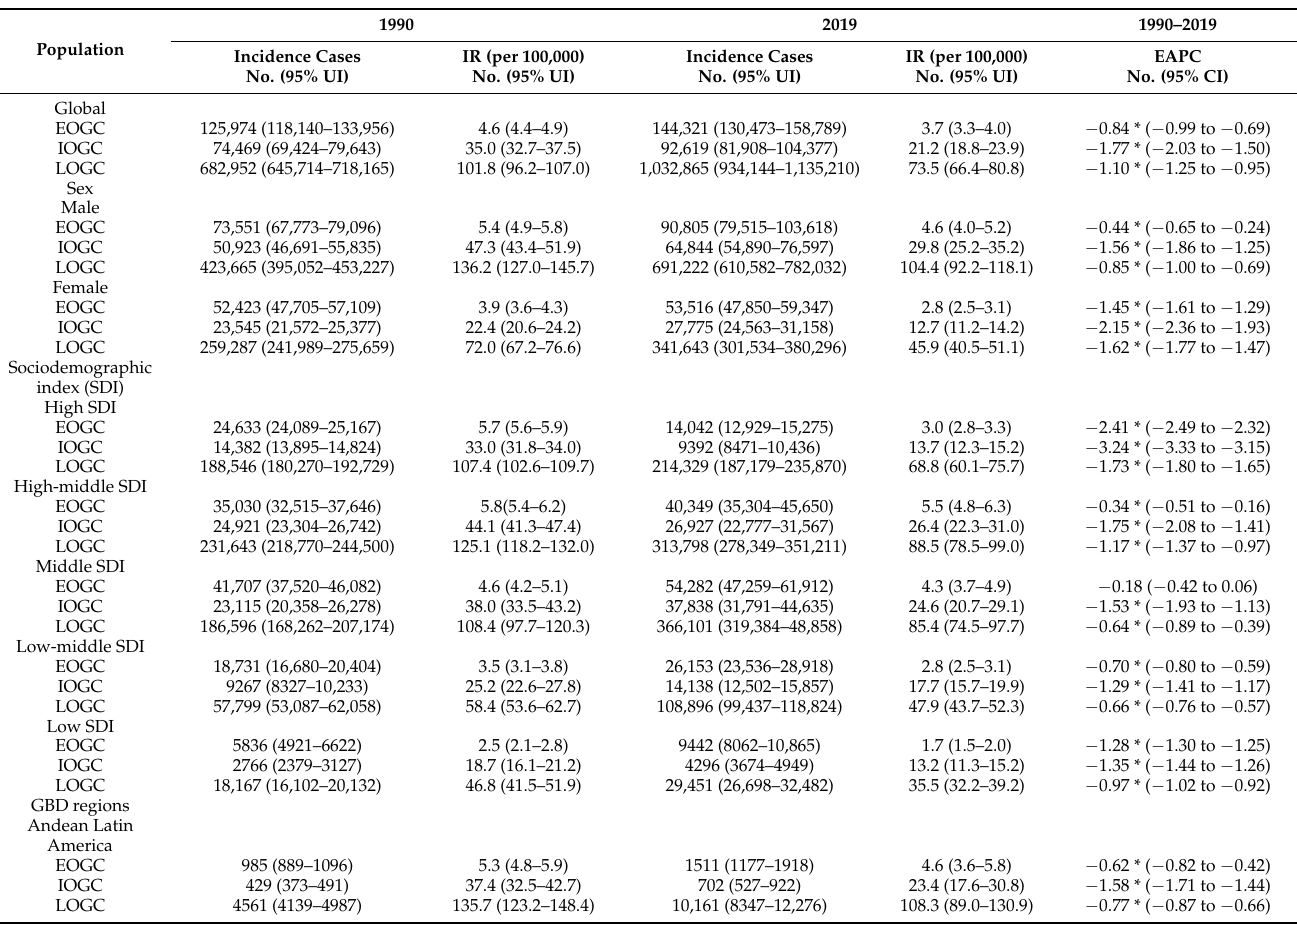
Table 1. Incidences and temporal trends in gastric cancers globally and by sex, and SDI and GBD regions,